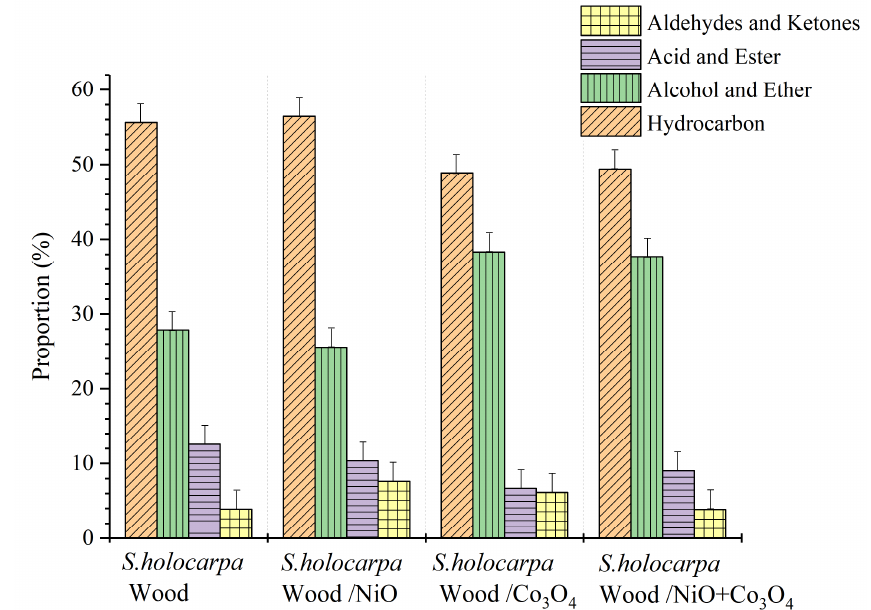
Figure 5. Proportion of pyrolysis products of S. holocarpa wood samples.